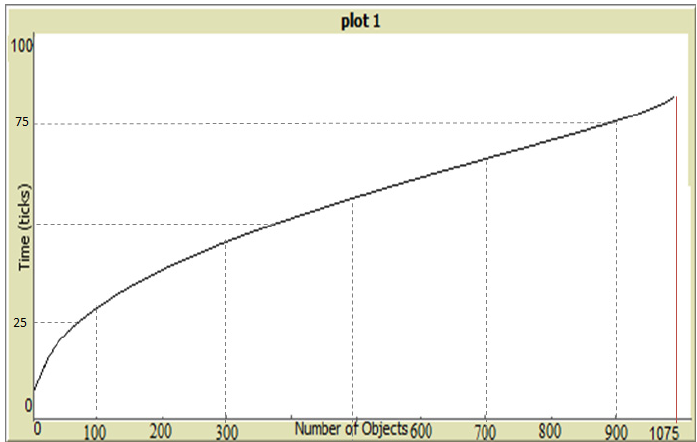
Figure 8. The scalability of the model handling 1000 objects.